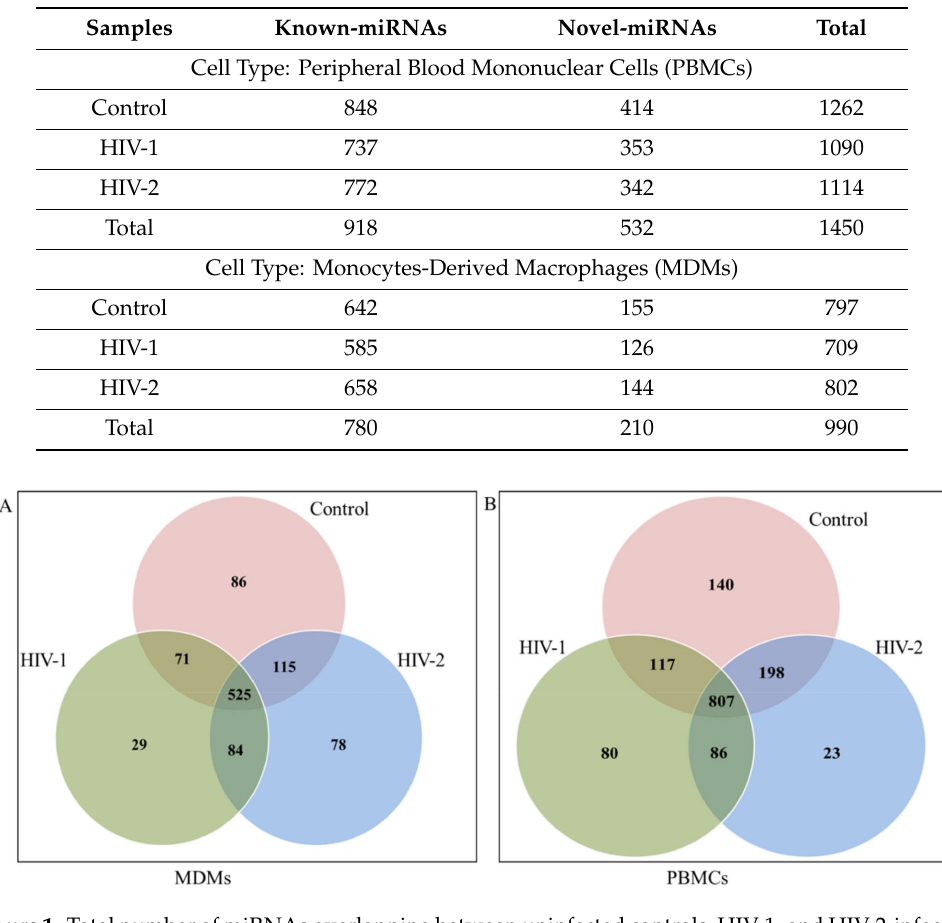
Figure 1. Total number of miRNAs overlapping between uninfected controls, HIV-1- and HIV-2-infected MDMs ( A ) and PBMCs ( B